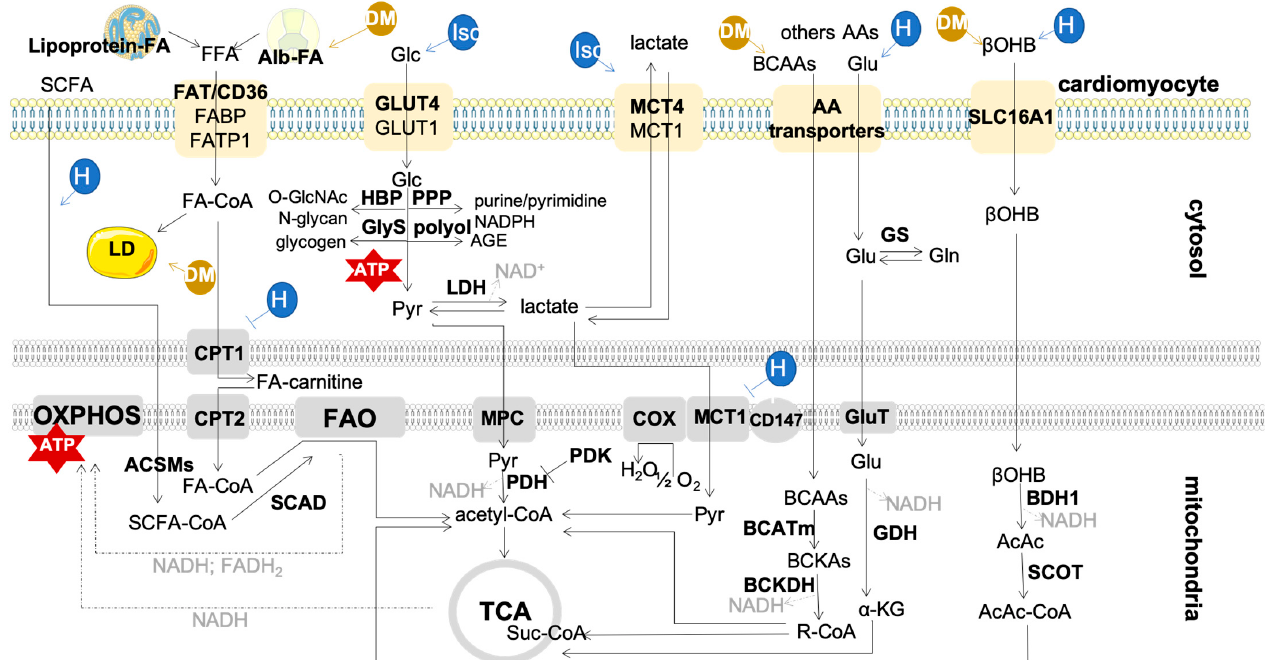
Figure 2. Energetic metabolism of cardiomyocytes. FFAs (free fatty acids), the main energetic fuel, are converted into long-chain acyl-CoA esters by fatty acyl CoA synthetase, and then, into long-chain acylcarnitine by CPT1, the rate limiting enzyme of long-chain FAO. Inside the mitochondria, long-chain acylcarnitine is converted back to long-chain acyl-CoA by CPT2, and then, several isoforms of acyl-CoA dehydrogenase, enoyl-CoA hydratase, 3-hydroxyacyl CoA dehydrogenase, and 3-ketoacyl CoA thiolase (specific for different chain lengths) mediate the shortening of the fatty acyl moiety, generating acetyl-CoA, FADH2, and NADH. Glc is transported by GLUTs (GLUT4 in adult heart) into cardiomyocytes, and, in the cytosol, Glc is converted into pyruvate through glycolysis. Pyruvate may be oxidized in mitochondria or converted into lactate by LDH in the cytosol. Lactate uptake and secretion is mediated by MCTs (MCT4 in the adult heart). MCT1 makes part of the mtLOC, which is also composed of CD147, LDH, and COX. Lactate may be oxidized in the mitochondria by this complex. Ketones, mostly β OHB, may feed TCA after being metabolized by the enzymes β -hydroxybutyrate dehydrogenase 1 (BDH1, the enzyme that interconverts β -hydroxybutyrate into acetoacetate) and succinyl-CoA:3-ketoacid CoA transferase (SCOT, the rate-limiting enzyme of ketone oxidation). SCFAs (including acetate, propanoate, and butyrate) can cross the mitochondrial membrane by diffusion, and enter FAO through SCAD, after being activated via ACSMs. BCAA and other amino acids, such as Glu, may be used for energetic purposes by feeding the TCA cycle. BCATm and BCKDH catalyze the first two enzymatic steps in BCAA metabolism. The contribution of these metabolic pathways changes in the injured heart. In ischemia (Isc), the reliance on glucose and lactate increases, but when insulin signaling is repressed, FAO is upregulated. During heart failure (HF) glucose oxidation prevails until mitochondria functionality is impaired, which happens at advanced stages of disease. In diabetes mellitus (DM), glucose uptake and oxidation decrease, inducing a higher reliance of cardiac metabolism on lipids for energetic purposes. Abbreviations: α -KG, α -ketoglutarate; β OHB, β -hydroxybutyrate; AA, amino acid; AcAc, acetoacetate; ACSMs, acyl-coenzyme A synthetase medium chain family members; AGE, advanced glycation end products; Alb, albumin; ATP, adenosine-5’-triphosphate; BCAA, branched chain amino acids; BCATm, mitochondrial branched-chain aminotransferase; BCKDH, branched-chain α -ketoacid dehydrogenase complex; BDH1, 3-hydroxybutyrate dehydrogenase 1; CD147, cluster of differentiation 147; COX, cytochrome c oxidase; CPT, carnitine palmitoyl transferase; DM, diabetes mellitus; FA-carnitine, acyl-carnitine; FA-CoA, long-chain acyl-CoA; FABP, fatty acid binding protein; FAO, fatty acid oxidation; FAT/CD36, fatty acid translocase; FATP, fatty acid transport protein; FADH 2 , reduced flavin adenine dinucleotide; GDH, glutamate dehydrogenase; Glc, glucose; Gln, glutamine; Glu, glutamate; GLUT, glucose transporter; GluT, glutamate transporter; GlyS, glycogen synthesis; GS, glutamine synthase; HBP, hexosamine biosynthetic pathway; HF, heart failure; Isc, ischemia; LD, lipid droplet; LDH, lactate dehydrogenase; MCT, monocarboxylate transporter; MPC,